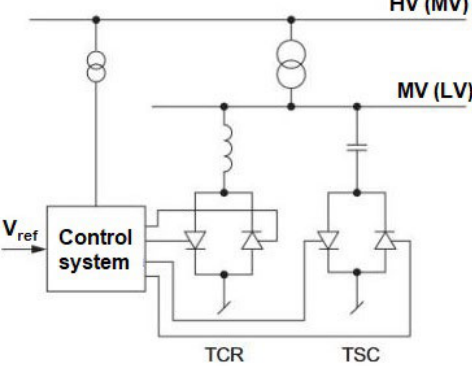
Figure 30. TCR/TSC compensator layout [35]: HV—high voltage, MV—medium voltage, LV—low voltage, and V ref —reference voltage.